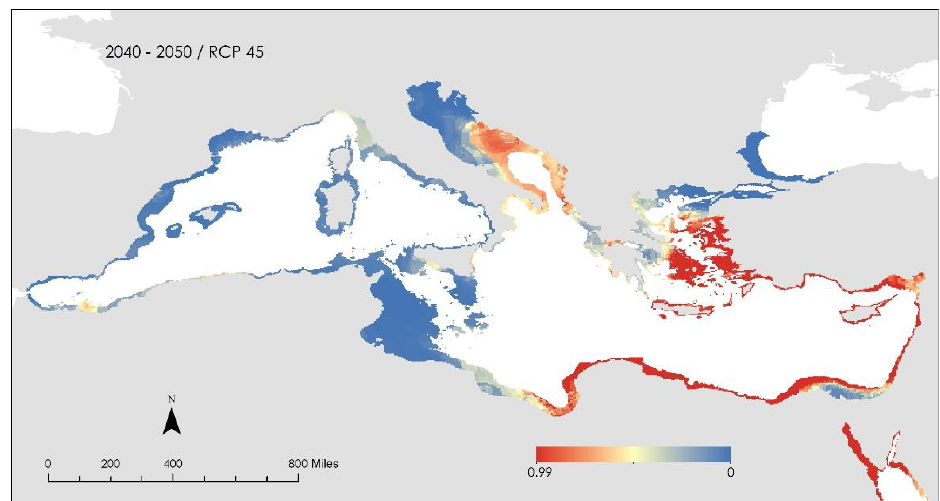
Figure 2. Lionfish potential distribution under RCP26 for the period 2040 – 2050.